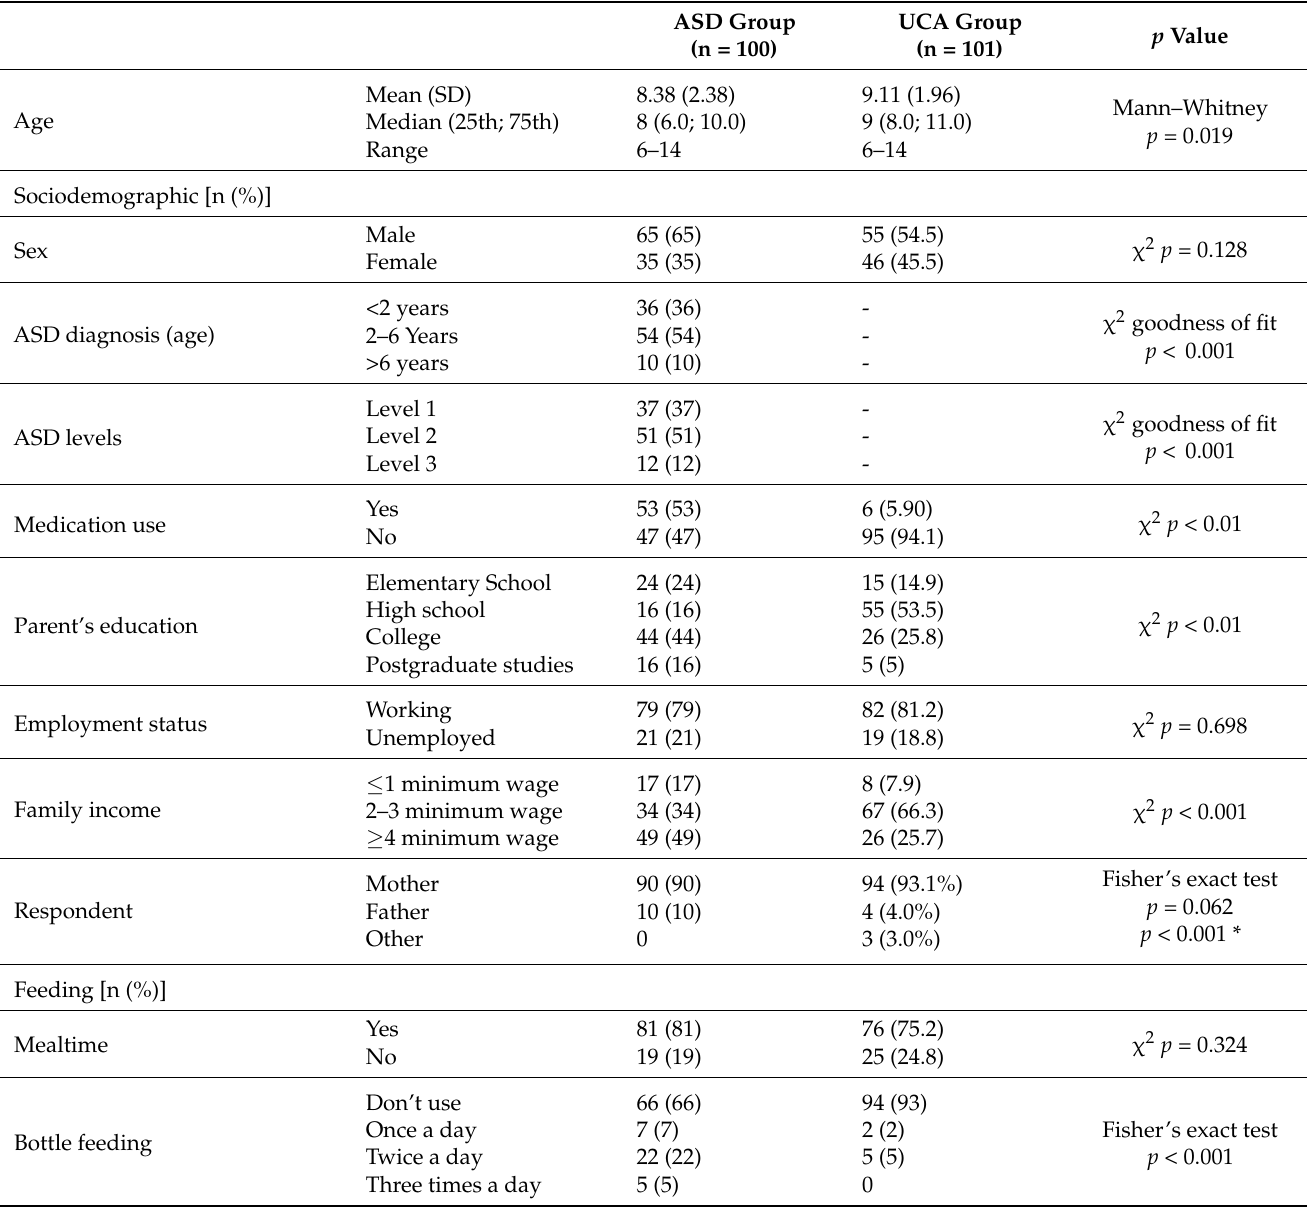
Table 1. Distribution of sociodemographic variables, oral habits, and dental care for both groups.